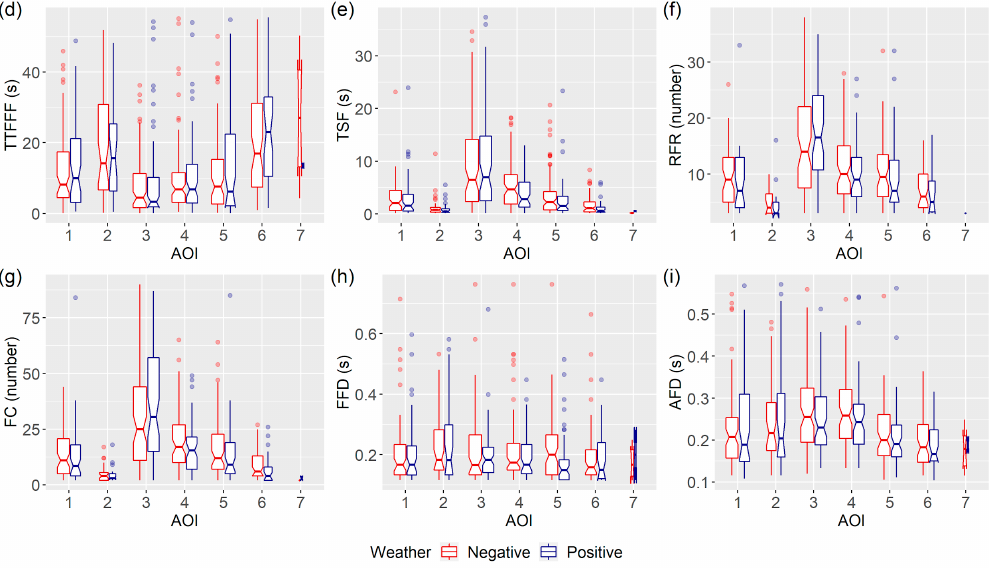
Figure 4. Statistic of chosen indexes: ( a ) HTG, ( b ) TSG, ( c ) RGR, ( d ) TTFFF, ( e ) TSF, ( f ) RFR, ( g ) FC, ( h ) FFD, ( i ) AFD (detailed description of indexes in the research area, data and methods chapter) for particular AOI in negative and positive weather for respondents with a good frame of mind (boxplots description according to Figure 3).